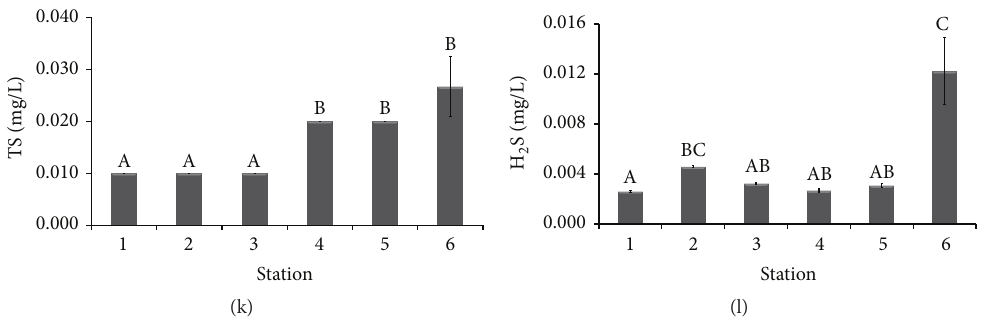
Figure 3: Ex situ water quality of (a) chlorophyll a (chl- a ), (b) total suspended solids (TSS), (c) five-day biochemical oxygen demand (BOD 5 ), (d) chemical oxygen demand (COD), (e) total nitrogen (TN), (f) total ammonia nitrogen (TAN), (g) nitrite nitrogen (NO 2− -N), (h) nitrate nitrogen (NO 3− -N), (i) total phosphorus (TP), (j) soluble reactive phosphorus (SRP), (k) total sulphide (TS), and (l) hydrogen sulphide (H 2 S) collected at the six sampling stations located at the upper reaches of two main tributaries of Batang Baleh (different letters indicate significant difference at 𝑝 value ≤ 0.05).